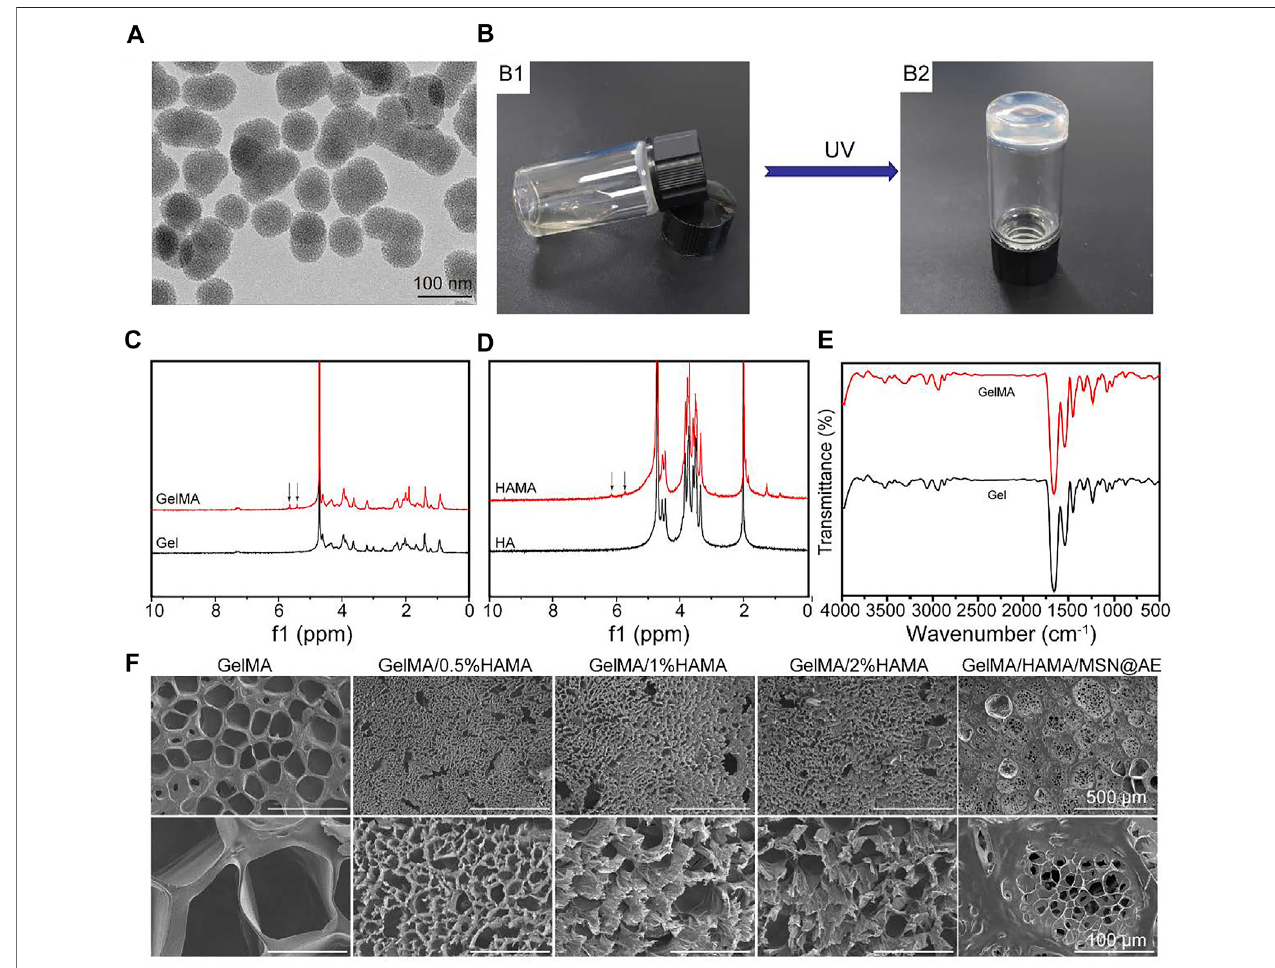
FIGURE1|(A) TEMimagesofMSN. (B) PhotographoftheGelMA/HAMAhydrogelthroughaUVcross-linking. (C) 1 HNMRspectraofGelandGelMA. (D) 1 HNMR spectra of HA and HAMA. (E) FTIR spectra of Gel and GelMA. (F) SEM images of GelMA/HAMA hydrogels with different HAMA